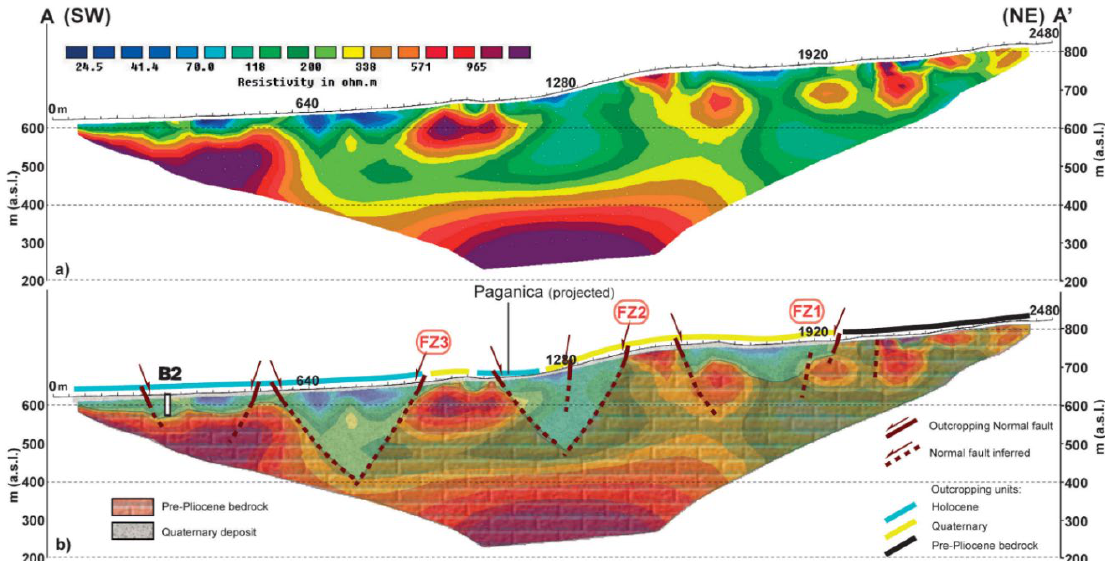
Figure 8. ( a ) Model of the first ERT profile obtained using a Wenner-alpha array configuration; ( b ) ERT interpretation of the tomographic image with the bedrock/basin infill bodies and main faults highlighted (Reprinted with permission from [38], Copyright (2016) Oxford University Press).